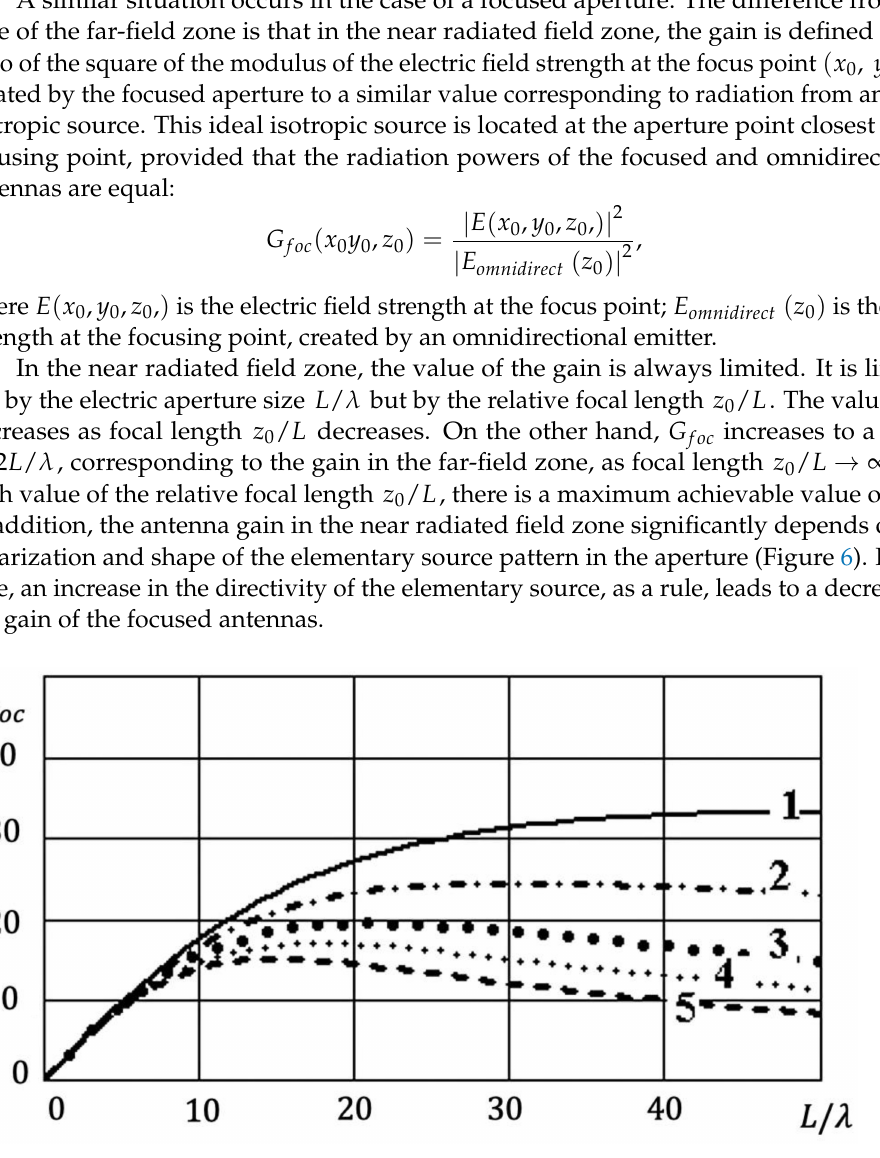
Figure 6. Dependence of G foc on the dimensions of the linear aperture for various polarization and radiation patterns of elementary sources with focusing depth z 0 = 7.5 λ . 1, isotropic emitter oriented across the aperture; 2, isotropic emitter oriented along the aperture; 3, radiation pattern type cos ( θ ) along the aperture; 4 and 5, emitters in the form of a Huygens element oriented across the aperture and along the